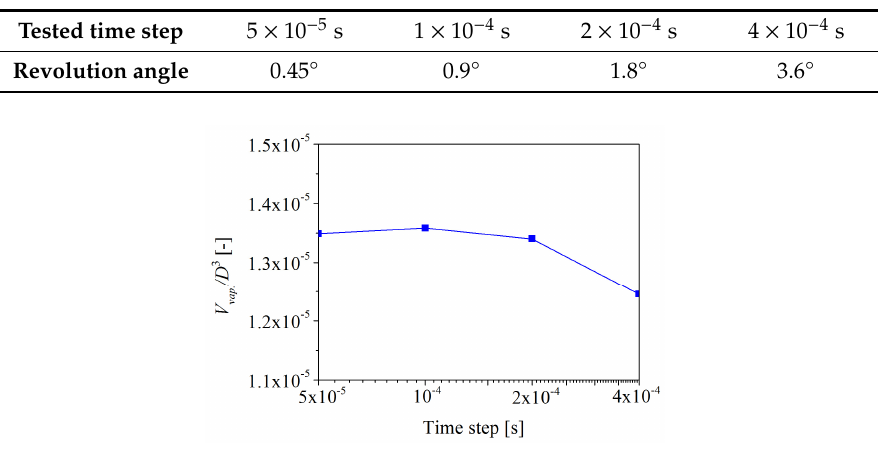
Figure 9. The e ff ect of time steps on vapor volume at J = 0.7. Figure 9. The effect of time steps on vapor volume at J = 0.7.